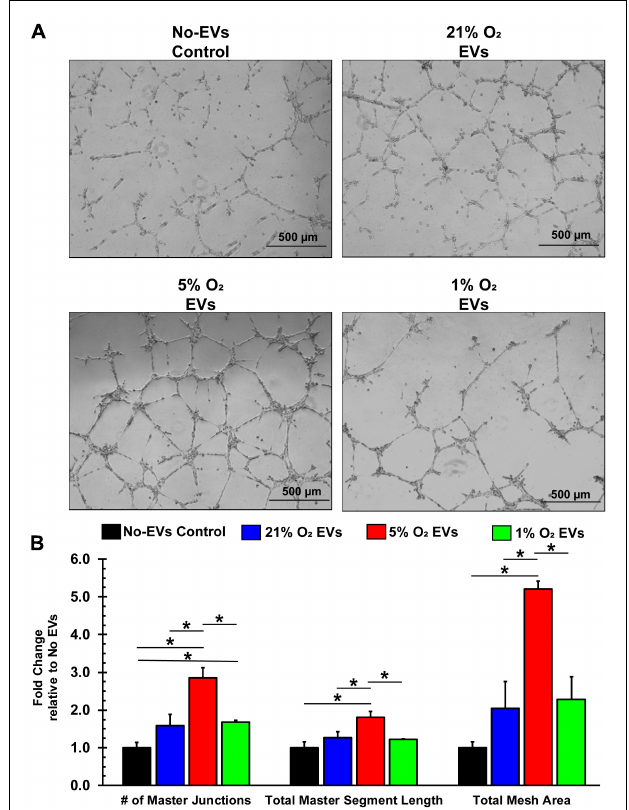
FIGURE 6 | EVs derived from hCPCs under physoxia enhances angiogenesis in vitro . BAECs were seeded onto Matrigel-coated wells with 100 µ g/ml of total EV protein from each condition and incubated for 16 h. (A) Representative images illustrate the degree of tube formation for each group. (B) 1% O 2 -derived EVs significantly increased tube formation in terms of the number of master junctions as compared to No-EVs control. However, 5% O 2 -derived EVs significantly increased tube formation as compared to all groups in terms of the number of master junctions, the total master segment length, and the total mesh area. Data shown represents mean ± SD, n = 3, * p < 0.05 for